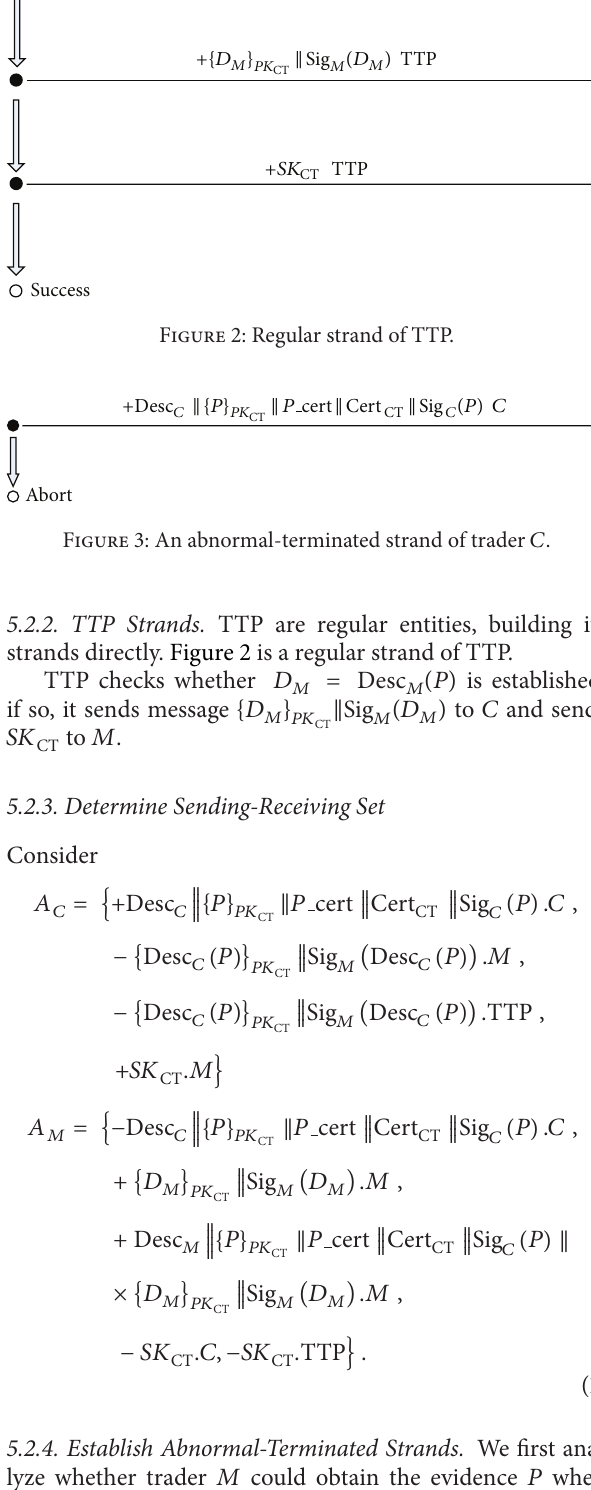
Figure 2: Regular strand of TTP.